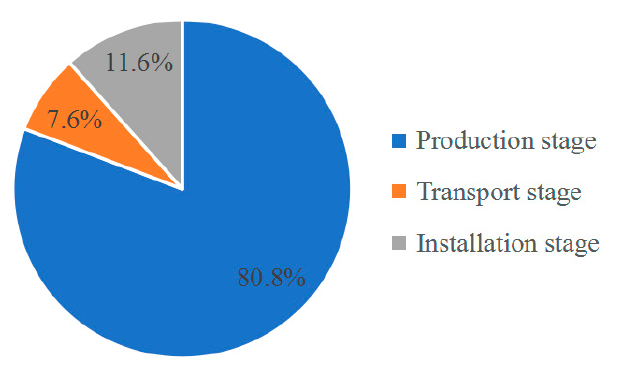
Figure 7. Proportion of carbon emissions at various stages in the whole construction process of CG-2 composite beams.